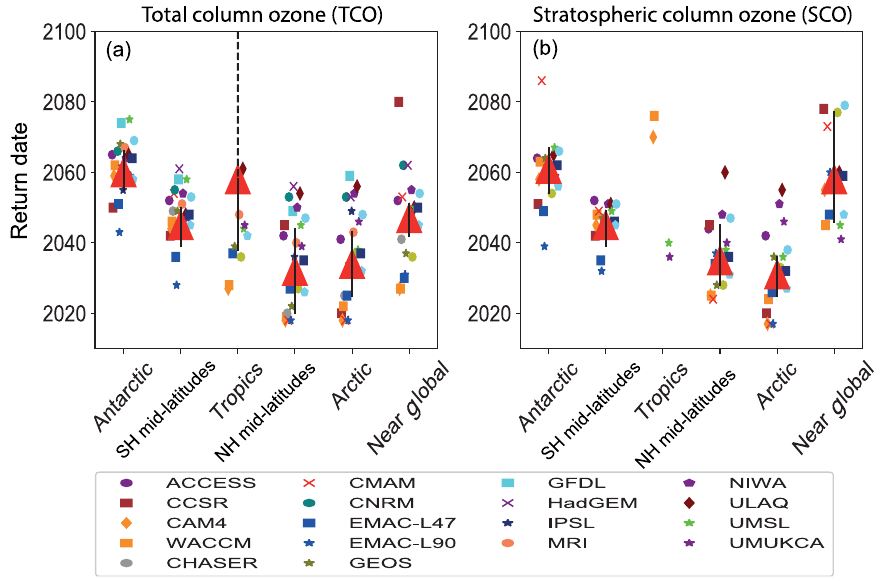
Figure 4. Estimated MMM1S return dates (red triangles) from the REF-C2 simulations for (a) total column ozone (TCO) and (b) strato- spheric column ozone (SCO) for different latitude bands. The estimated 1 σ uncertainties are shown with vertical black lines. Estimates for individual models are shown with coloured dots. Some individual models do not predict a return of column ozone in the tropics and so this uncertainty is indicated by a dashed